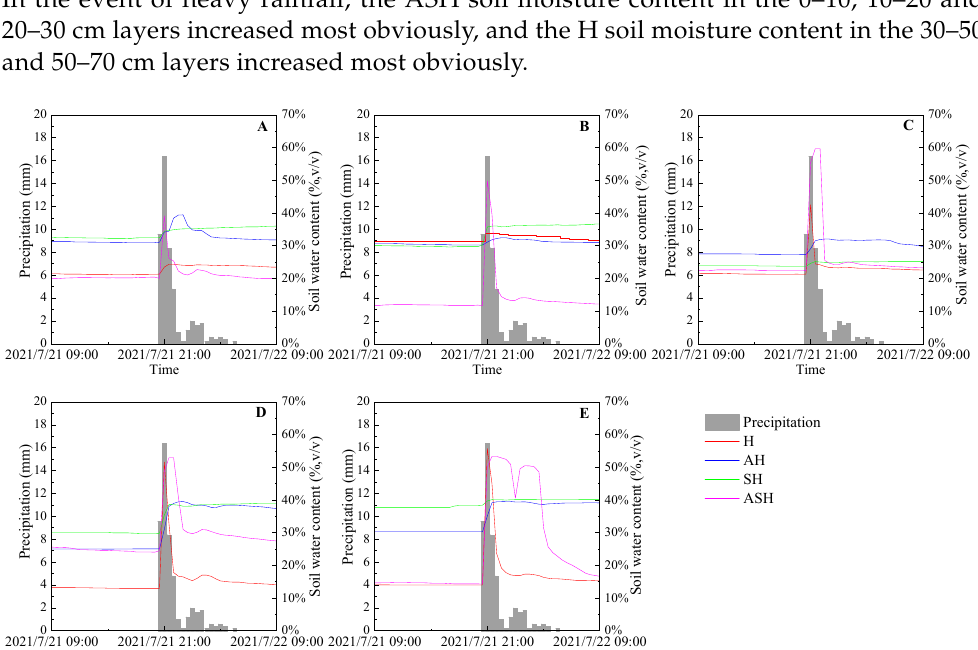
Figure 6. The variations of soil moisture content at moderate rain event. (A) 0 – 10 cm, (B) 10 – 20 cm,